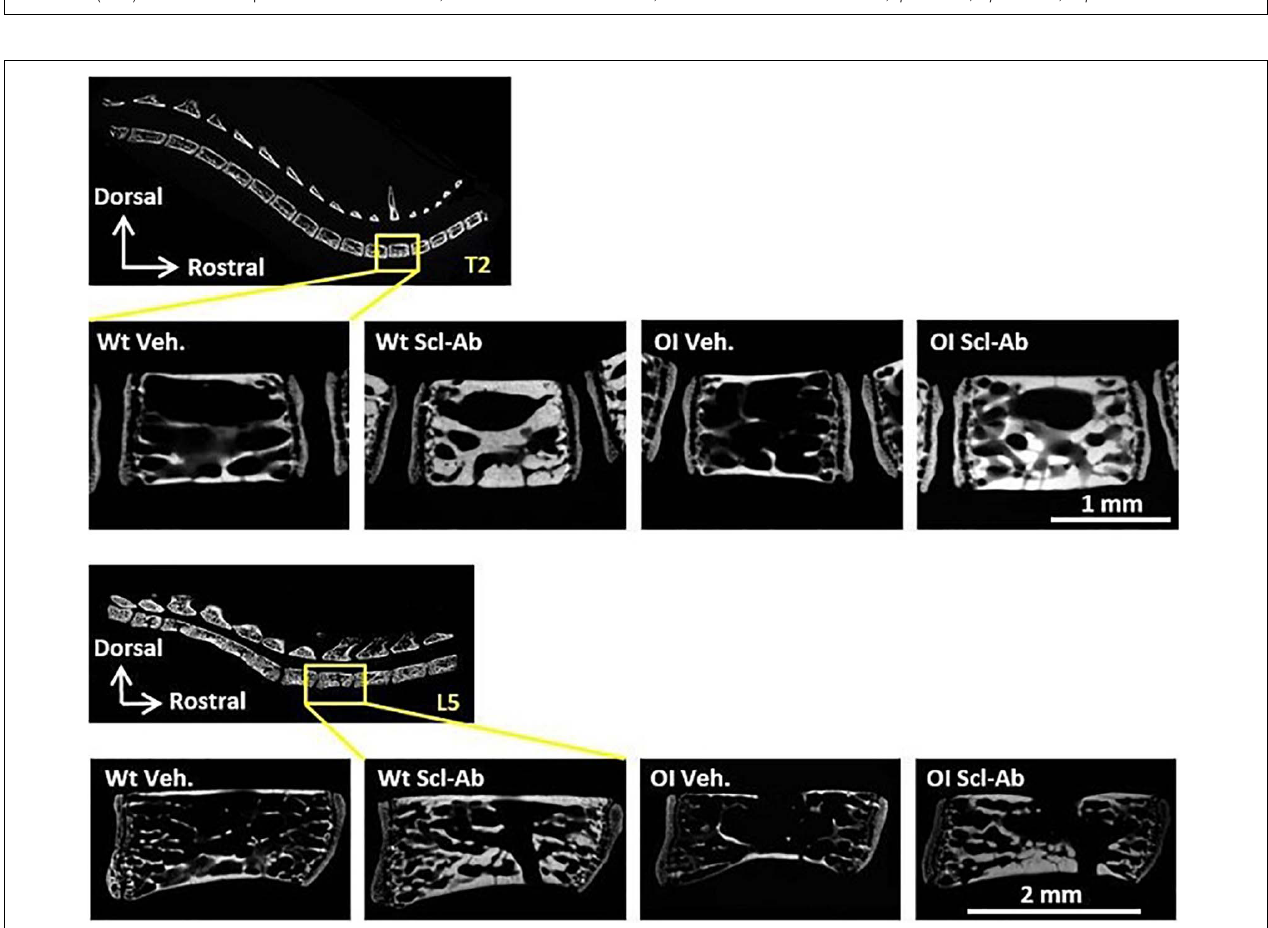
FIGURE 4 | Microradiograph of sagittal undecalcified sections through T2 and L5 vertebral bodies of male Wt Veh., Wt Scl-Ab, OI Veh., and OI Scl-Ab mice.